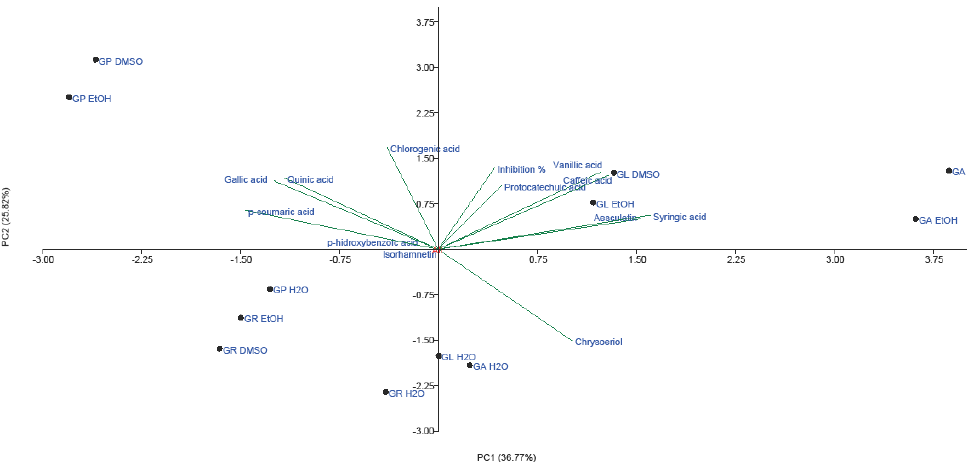
Figure 5. PCA of quantified phenolic compounds and AV activity of both H 2 O and EtOH extracts and EtOH extract solution in 5% DMSO of G. applanatum , G. lucidum , G. pfeifferi and G. resinaceum .